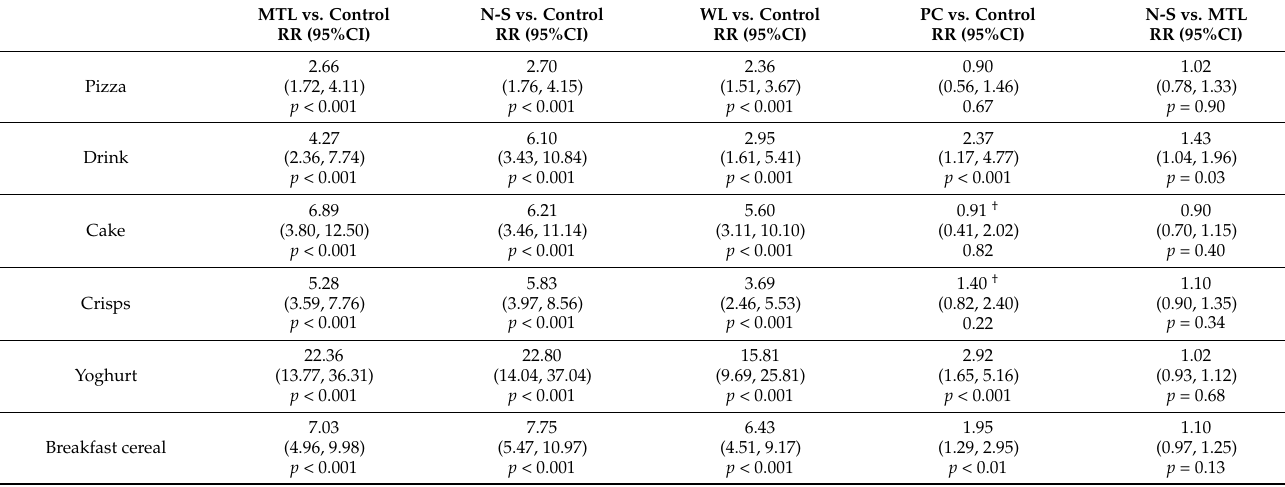
Table 4. Log-binomial regression results–relative risk that ranking improved (follow-up vs. baseline) between FOPL group and control (adjusted for design factors and covariates as planned).